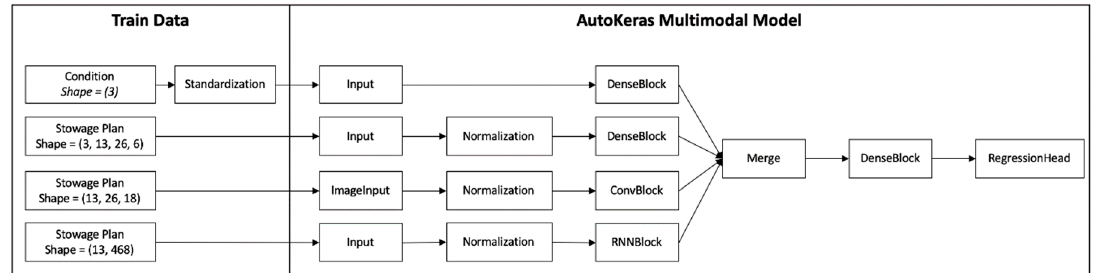
Figure 8. Multimodal model with AutoKeras.